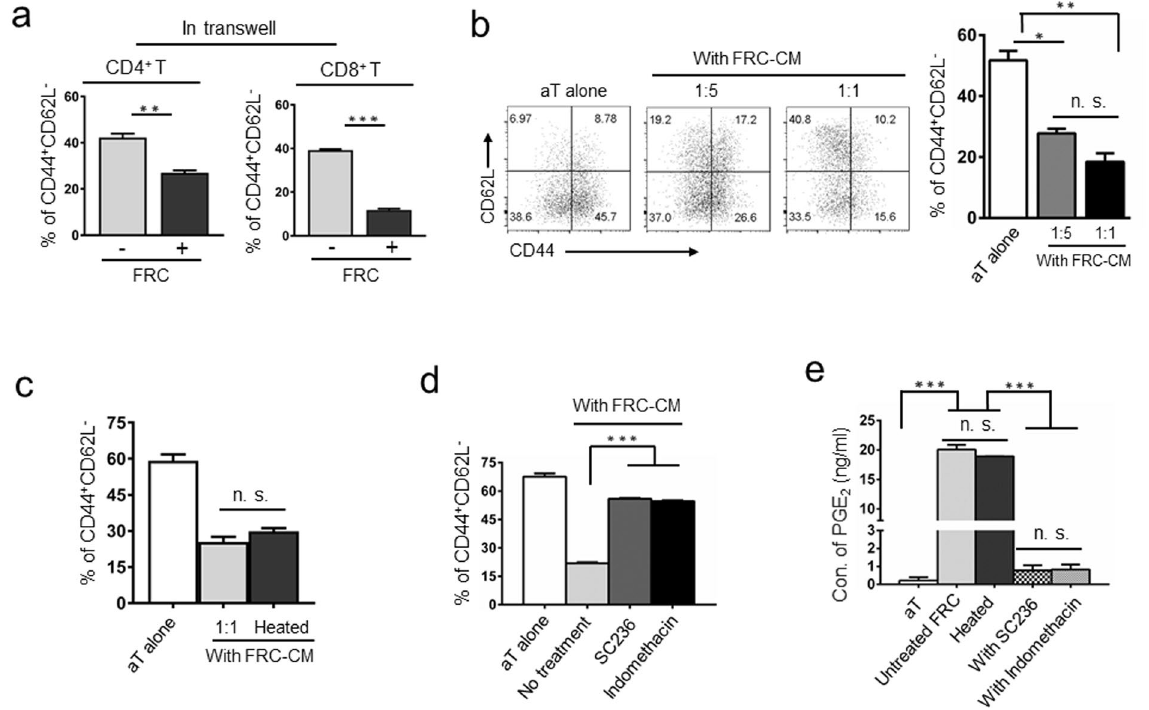
Figure 3. FRCs suppress T cell activation through secretion of heat-stable soluble factors. ( a ) T cells were activated in transwell plates where they were placed with activation beads in the upper chamber and separated from FRCs in the lower compartment by a permeable membrane (1.0 μ m). T cell activation was assessed by flow cytometry as changes in the expression of CD44 and CD62L. ( b ) FRC-conditioned medium (FRC-CM), supernatant harvested from a FRC overnight-culture, was added to T cell activation assay at the dilution of 1:1 or 1:5. The percentage of activated CD44 + CD62L − cells is summarized as bar chart. ( c ) FRC-CM was heated to 100 °C for 5 min. The chilled medium was added to T cell activation assay at the dilution of 1:1. n.s. = not significant. ( d ) FRC-CM from the FRC culture in the presence of COX-2 selective inhibitor SC236 (5 μ M) or COX-2 non-selective inhibitor indomethacin (1 μ M) for 24 h were collected and added to T cell activation assay at 1:1 dilution. The percentage of activated CD44 + CD62L − cells was determined via flow cytometry. ( e ) PGE 2 concentration in the supernatant of activated T cells and FRC-CM in the absence or presence of various inhibitors was determined via ELISA. Data ( a – e ) are representative of two to three independent experiments (mean ± SEM; * P < 0.05, ** P < 0.01, *** P < 0.001; nonparametric Mann-Whitney